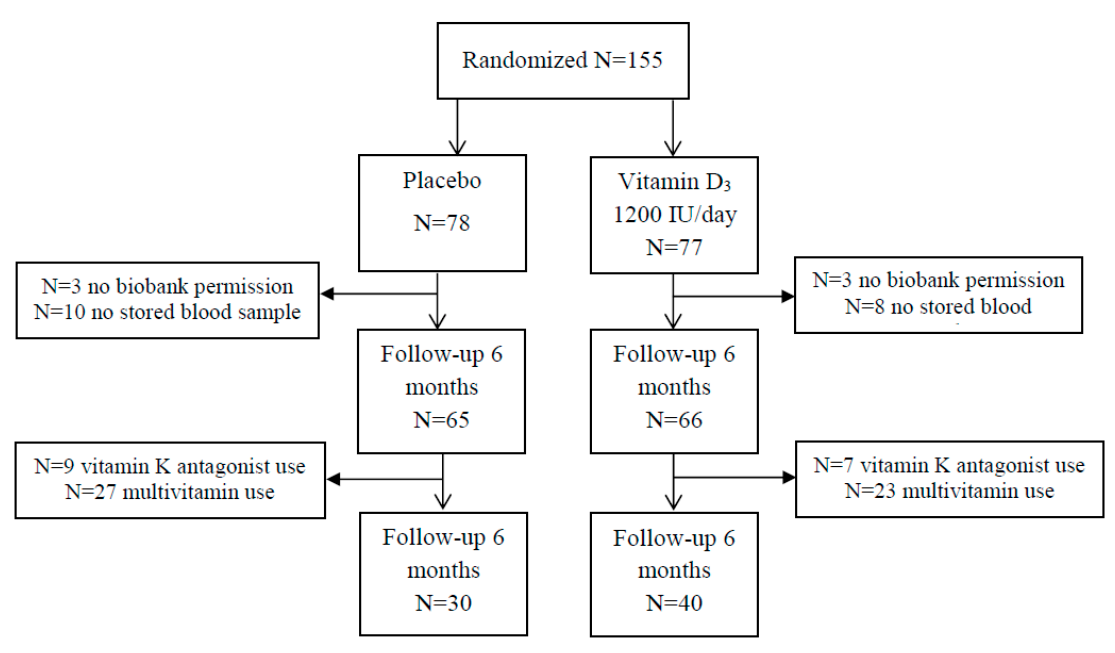
Figure 1. Flow chart of randomization. Due to combined use of vitamin K antagonist use and multivitamin use, the numbers are higher in the final population ( n = 1, placebo; n = 4, vitamin D group).